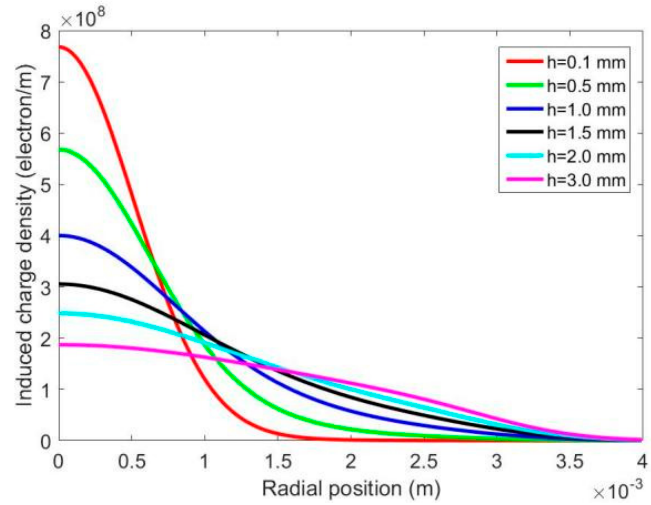
Figure 3. Variation of induced charge cloud radius with different substrate thickness.